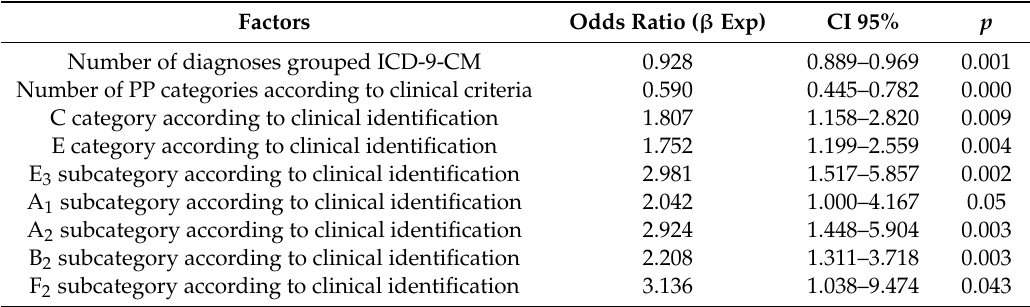
Table 3. Factors associated with the correct identification of PP using ICD-9-CM coding (with respect to the gold standard clinical identification method).